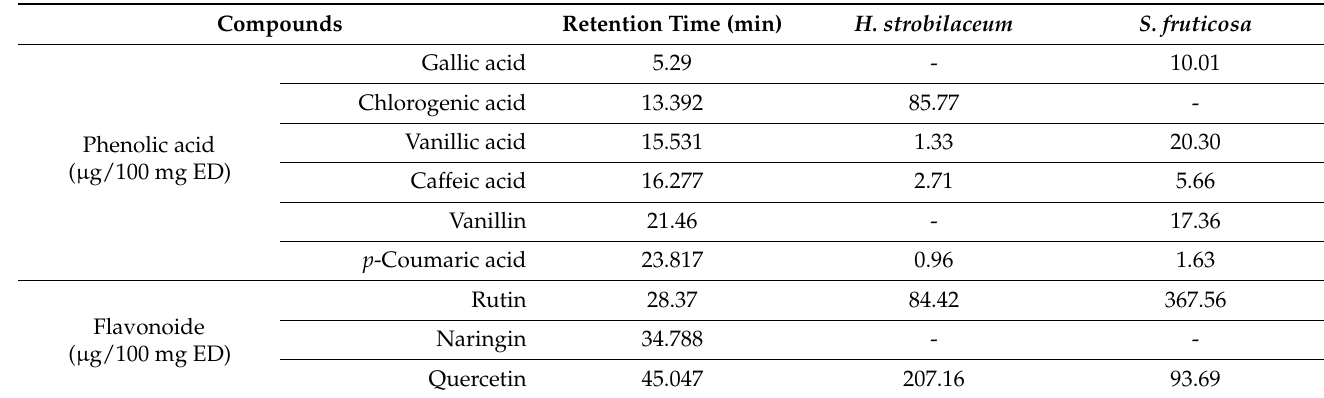
Table 5. Content of individual phenolic acids and flavonoids in the hydro-methanolic H. strobilaceum and S. fruticosa extracts.